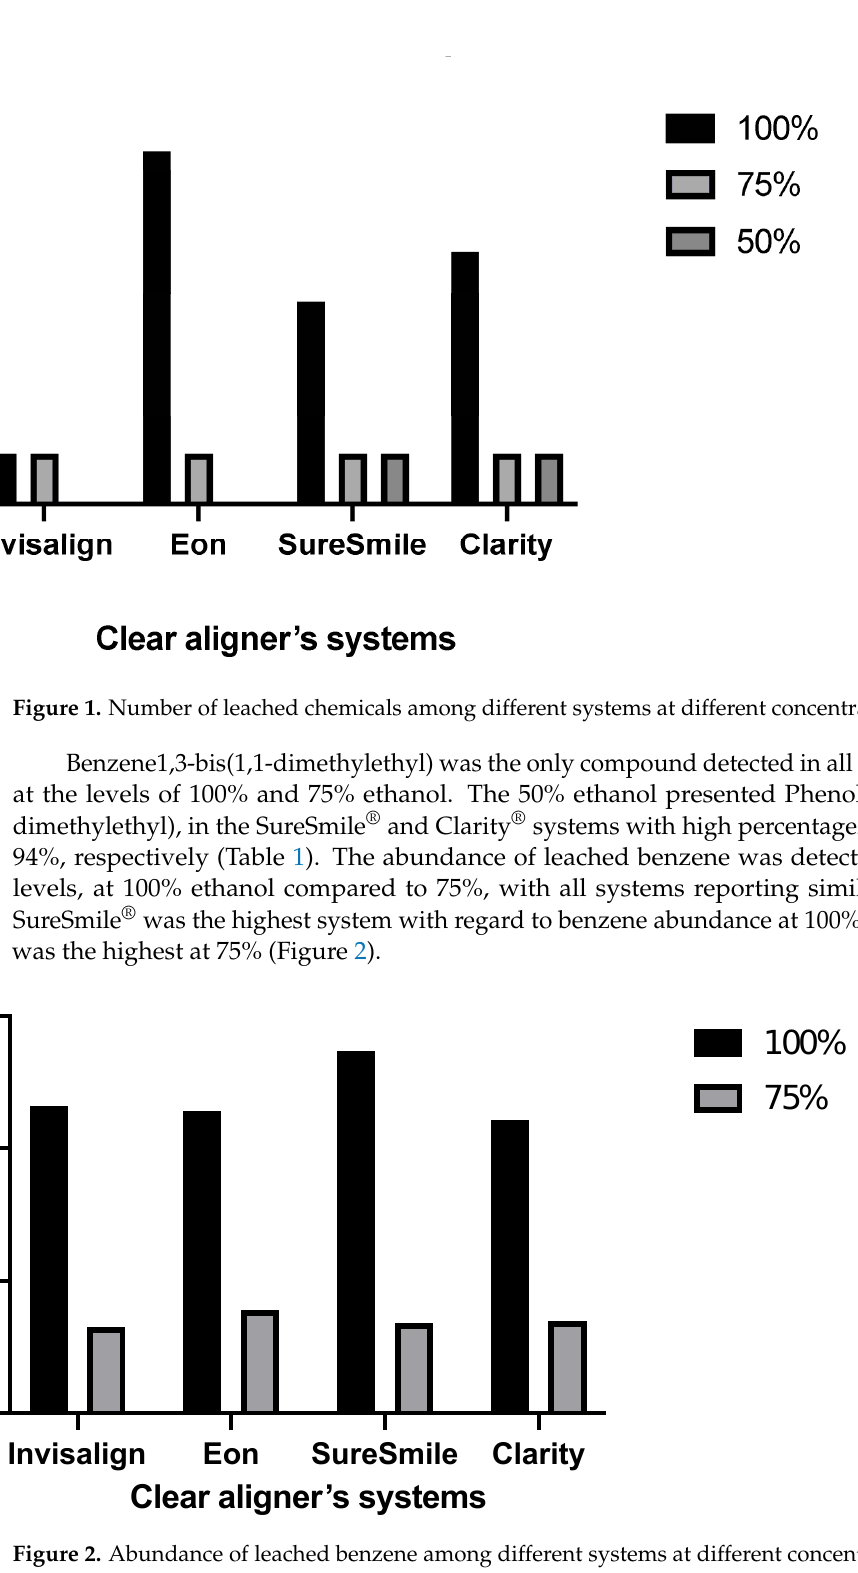
Figure 2. Abundance of leached benzene among different systems at different concentrations. Leaching was confirmed from the different systems at variable immersion solution concentrations (Table 2). Furthermore, only the Eon ® system showed statistically significant differences when comparing the number of leached substances among the immersion solution concentrations (Table 3). Seven different leached chemical compounds were observed in a 100% immersion solution of the Eon ® system compared to a single